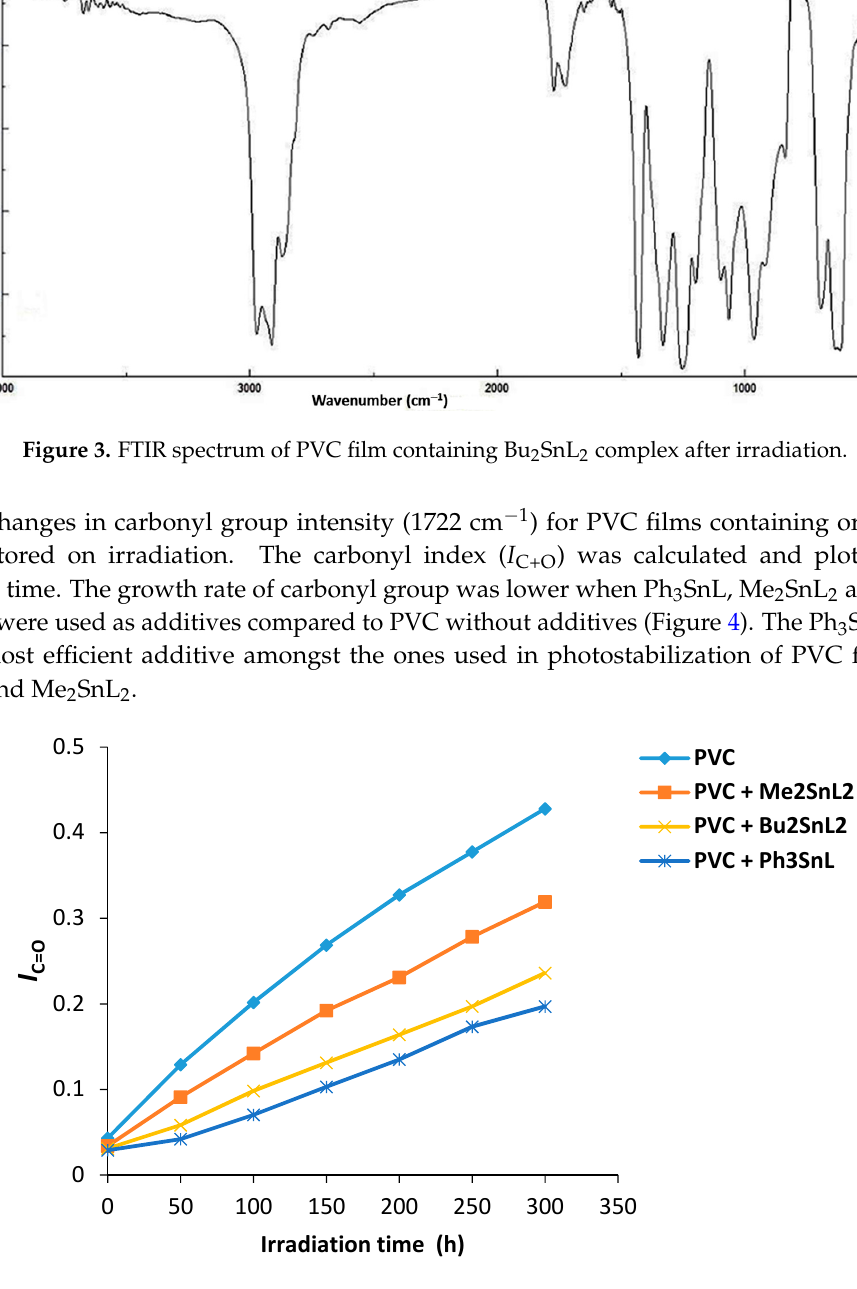
Figure 4. Changes in the I C=O index for PVC films versus irradiation time.